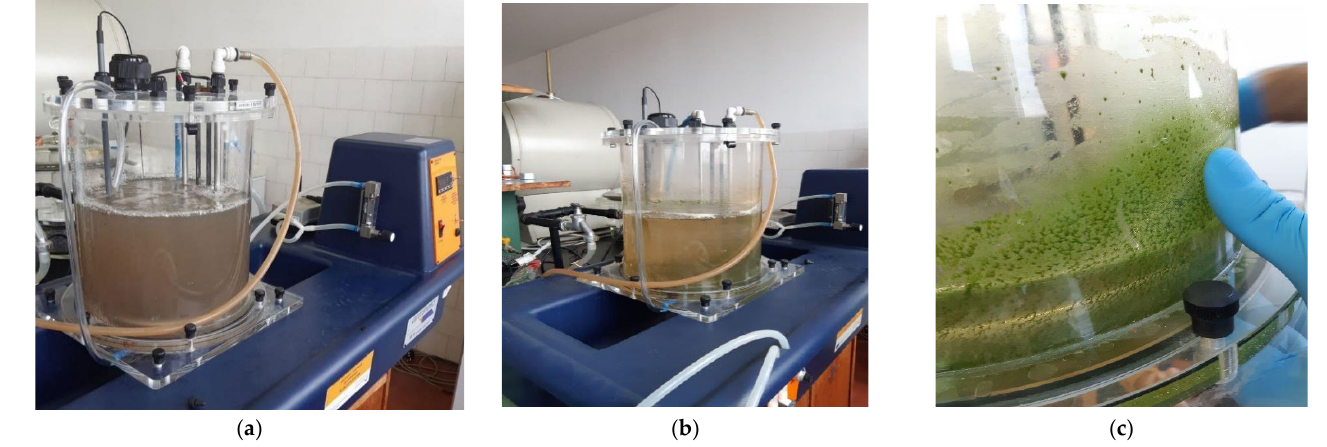
Figure 2. Photo of bioreactor during wastewater treatment using Chlorella vulgaris at the time of the preliminary experiment. ( a ) Wastewater in the bioreactor on the 1st day of microalgae inoculation. ( b ) Wastewater in the bioreactor after 4 weeks of treatment. ( c ). Biomass accumulation on the walls of bioreactor.